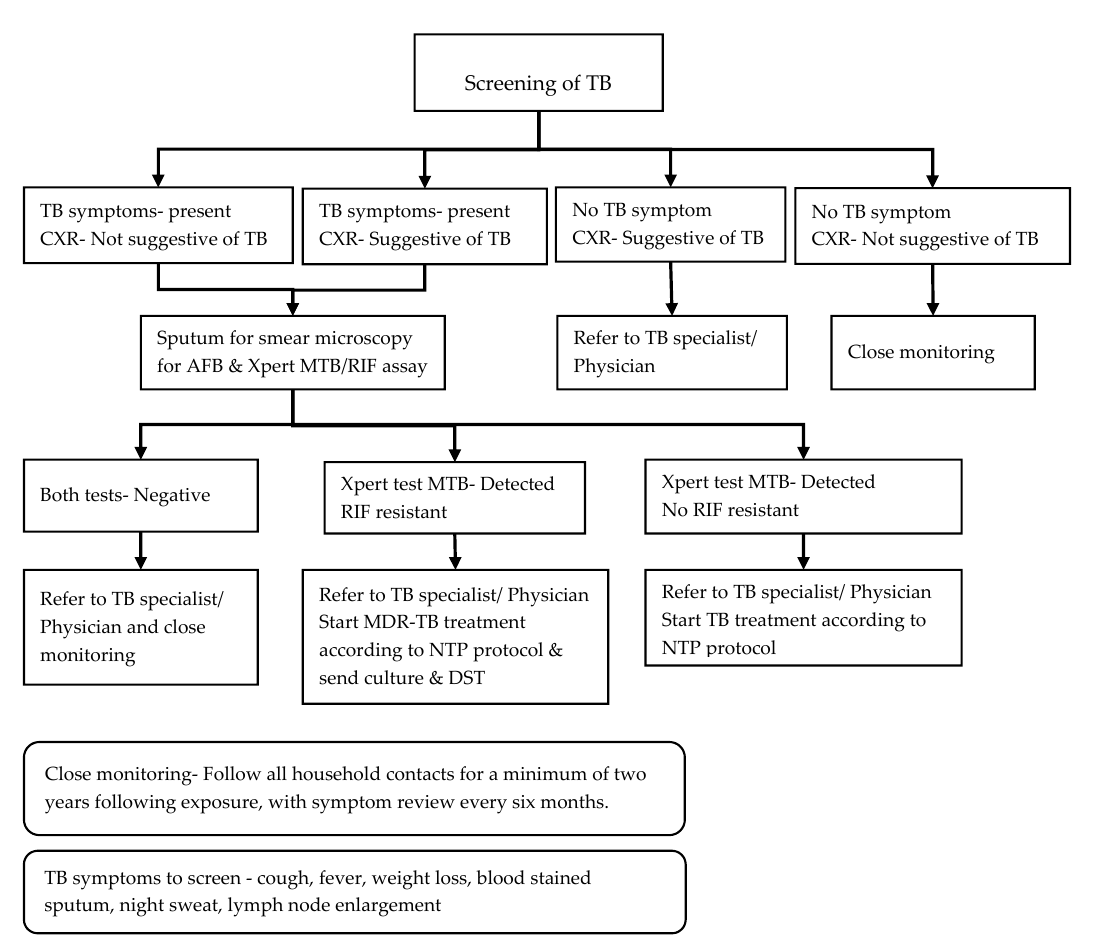
Figure 1. Systematic screening and investigation algorithm for household contacts of index multidrug-resistant tuberculosis (MDR-TB) patients in the community-based MDR-TB care project in Myanmar. TB = tuberculosis; CXR = chest radiography; AFB = acid-fast bacilli; NTP = National TB Programme; DST = drug sensitivity testing.